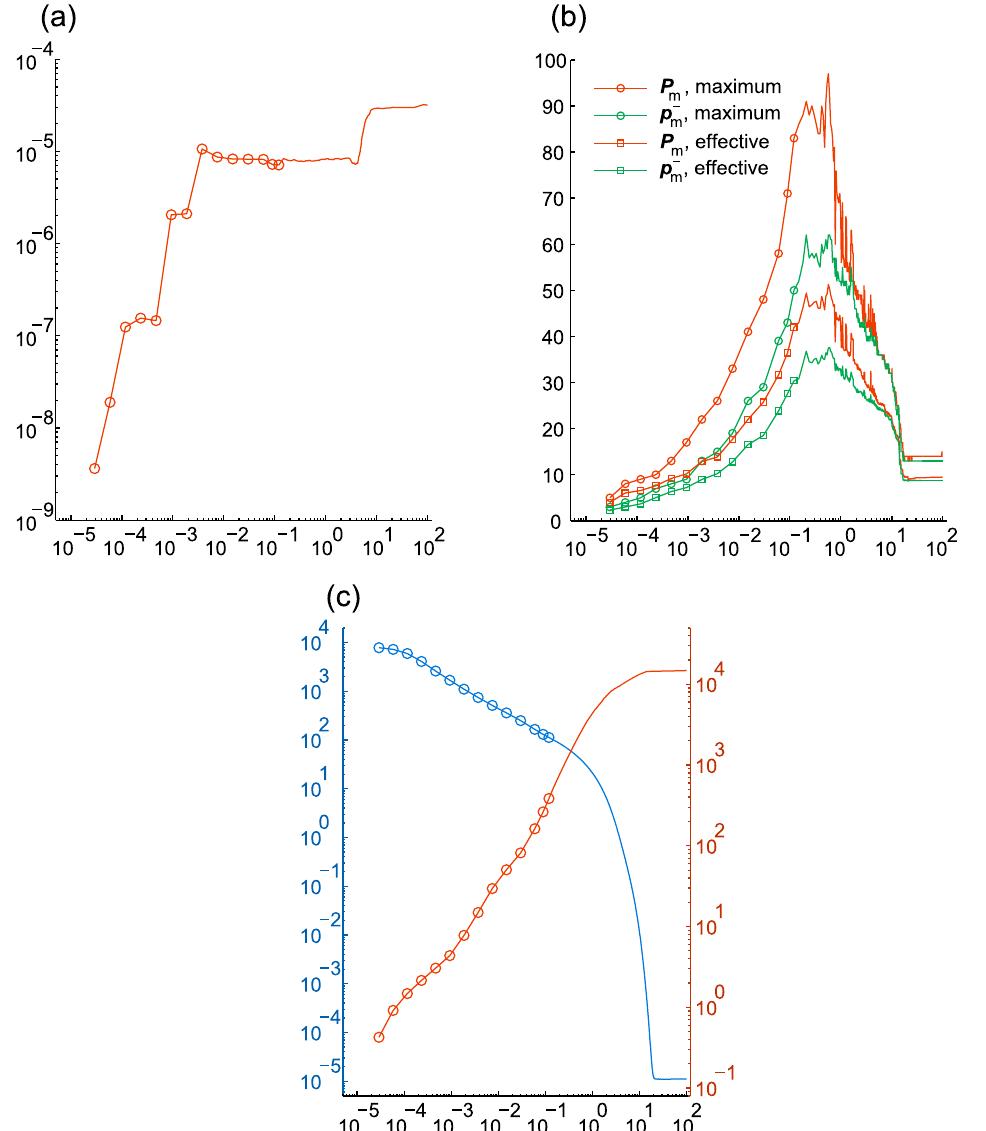
(cid:12) (cid:13) . (b) m